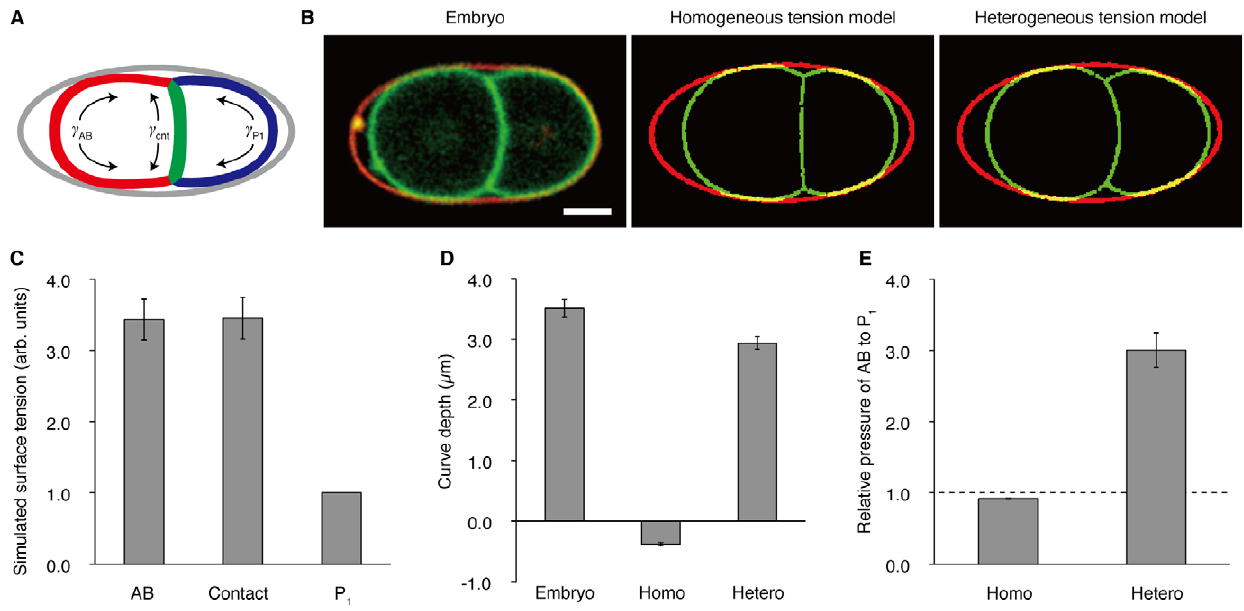
Figure 6. Computer simulation of the homogeneous and heterogeneous tension models. (A) Graphical representation of the simulation model. Gray, the eggshell; red, the outer surface of AB; blue, the outer surface of P 1 ; green, the contact surface. c AB , c P1 , and c cnt denote the surface tension parameters. (B) Left, a confocal image of an embryo that has the GFP-tagged plasma membranes and the TRITC-stained eggshell. Center, a simulated cell shape using the homogeneous tension model. Right, a simulated cell shape using the heterogeneous tension model. (C) Surface tension parameters that made the heterogeneous tension model most similar to the GFP::PH embryos. The results of 20 simulations that correspond to the 20 observed embryos are shown. AB, surface tension parameter c AB . Contact, surface tension parameter c cnt . P 1 , surface tension parameter c P1 . (D) Curve depth of the contact surfaces. Embryo, GFP::PH embryos; Homo, the homogeneous tension model; Hetero, the heterogeneous tension model. (E) Ratios of the simulated pressures between AB and P 1 . The values indicated are the ratio P AB / P P1 , where P AB is the pressure inside AB, P P1 is the pressure inside P 1 . Error bars indicate s.e.m. Scale bars, 10 m m.